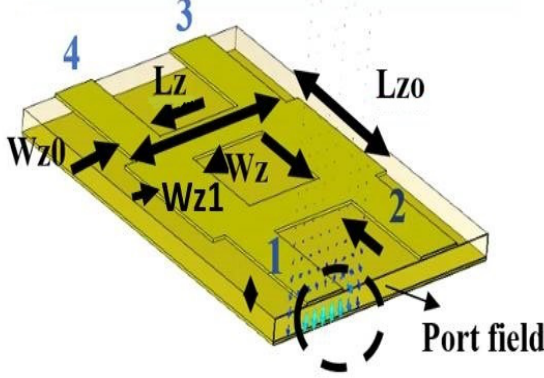
Figure 11. Hybrid structure topology dimensions.